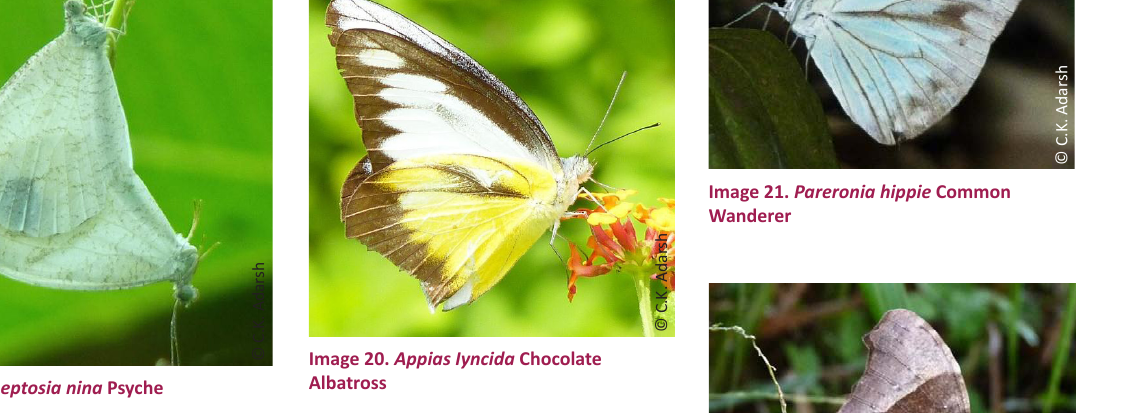
Image 19. Leptosia nina Psyche